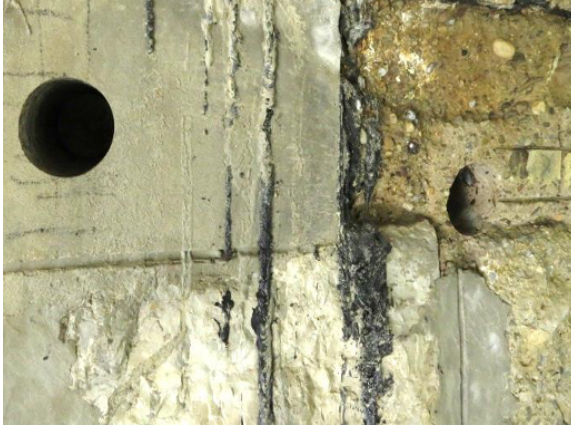
Figure 3. Places where drilled core samples were taken from the bridge abutment - on the left: the site with the protective render coat and on the right: the place where the render spalled over time (Bridge in Sládkovi č